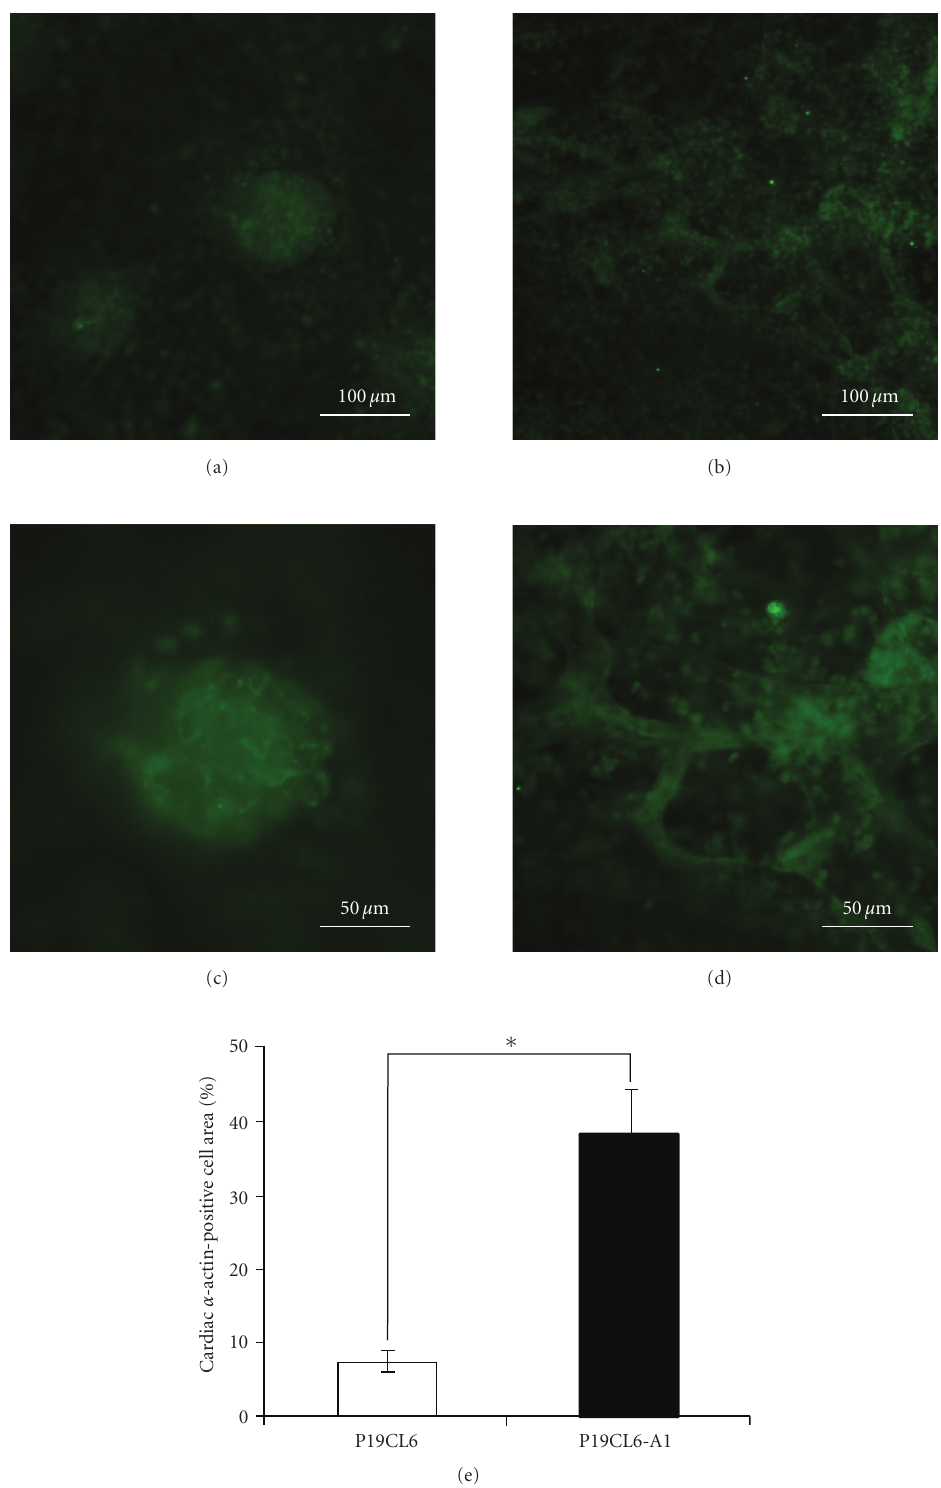
Figure 2: Immunofluorescence staining with anticardiac α -actin antibody in P19CL6 cells di ff erentiated by the basal protocol on day 16 ((a) and (c)), and P19CL6-A1 cells by the developed protocol on day 16 ((b) and (d)). ((a) and (c)) Cardiac α -actin-positive cells, various in shape, form relatively small and round clusters. ((b) and (d)) Cardiac α -actin-positive cells, relatively large and elongated in general, formed mesh-like sheet structures. (e) Quantitative analysis of rates of di ff erentiation into cardiomyocytes. Ratios of α -actin-positive cell areas to total areas of microscopic fields were calculated based on a total of 60 micrographs randomly taken from six independent experiments in each cell type and summarized as mean ± SE. Unpaired t -test was carried out to compare the di ff erentiation e ffi ciency between the two cells. ∗ P < .